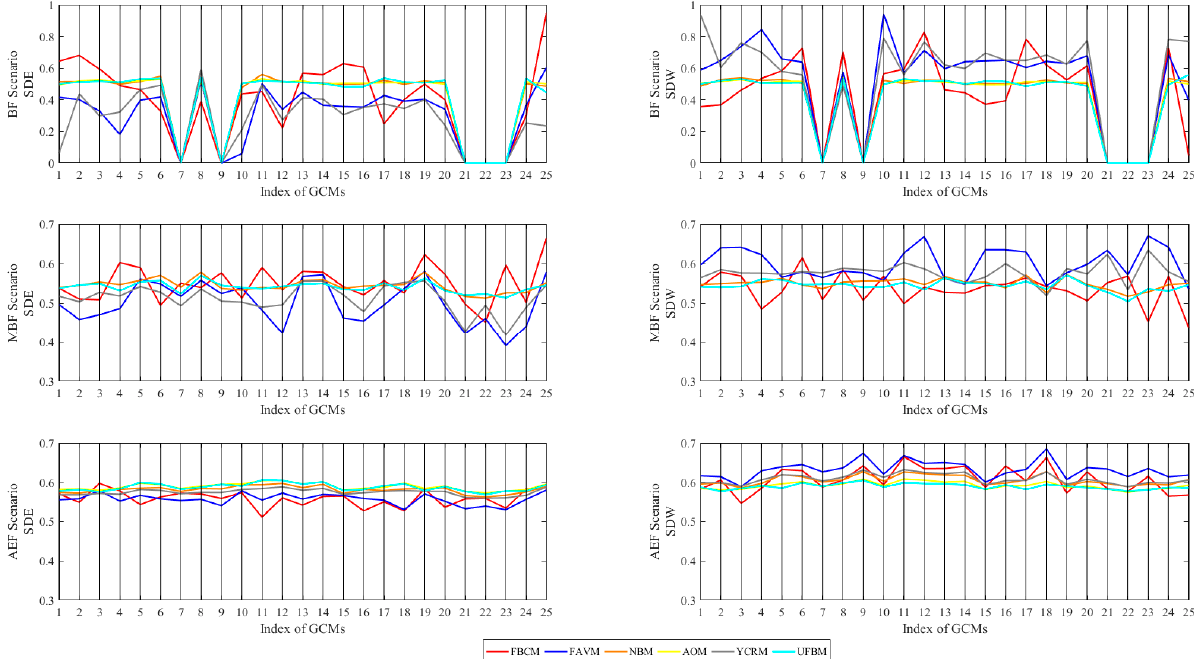
Figure 9. SDE and SDW obtained by six conflict-resolution methods under different GCMs and EF patterns (FBCM: fuzzy